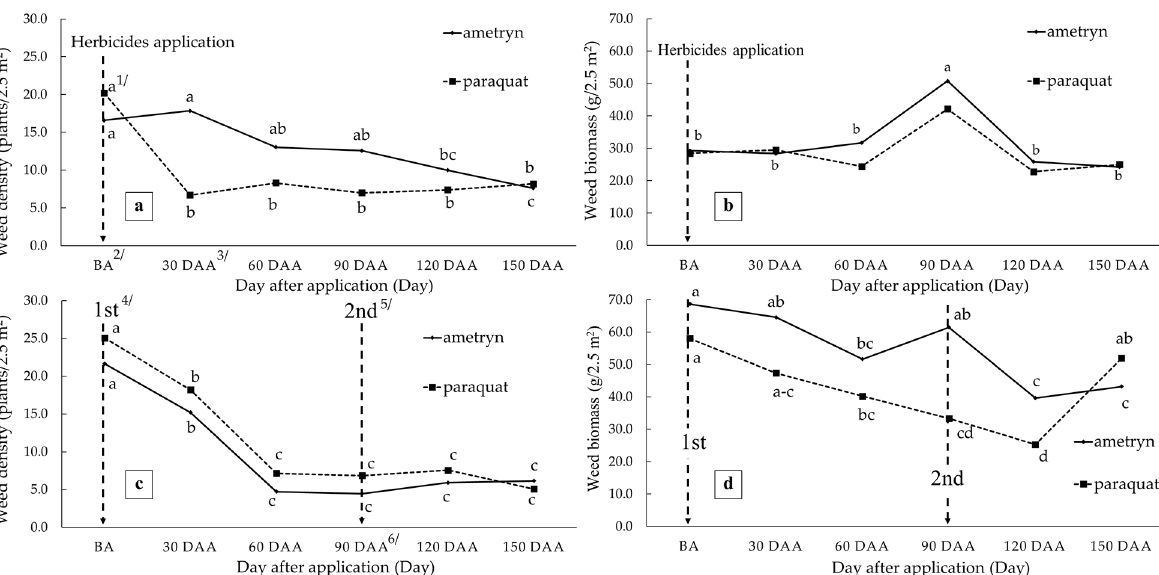
Figure 4. Effects of ametryn and paraquat applications in Experiment I and Experiment II on weed density and weed biomass; ( a ) weed density in Experiment I, ( b ) weed biomass in Experiment I, ( c ) weed density in Experiment II, and ( d ) weed biomass in Experiment II. 1 / Means in the same lowercase letter within the same herbicide line are not significantly different by LSD at p < 0 . 05, 2 / before application, 3 / days after application, 4 / herbicide application the first time, 5 / herbicide application the second time, and 6 / before second time application.